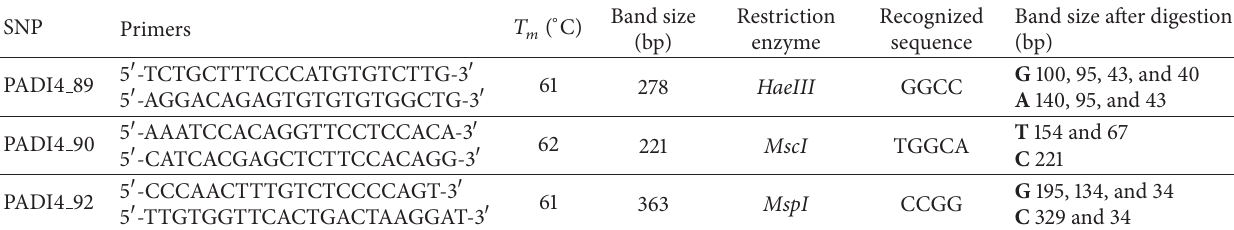
Table 1: Genotyping strategies for PADI4 polymorphism variants detection.